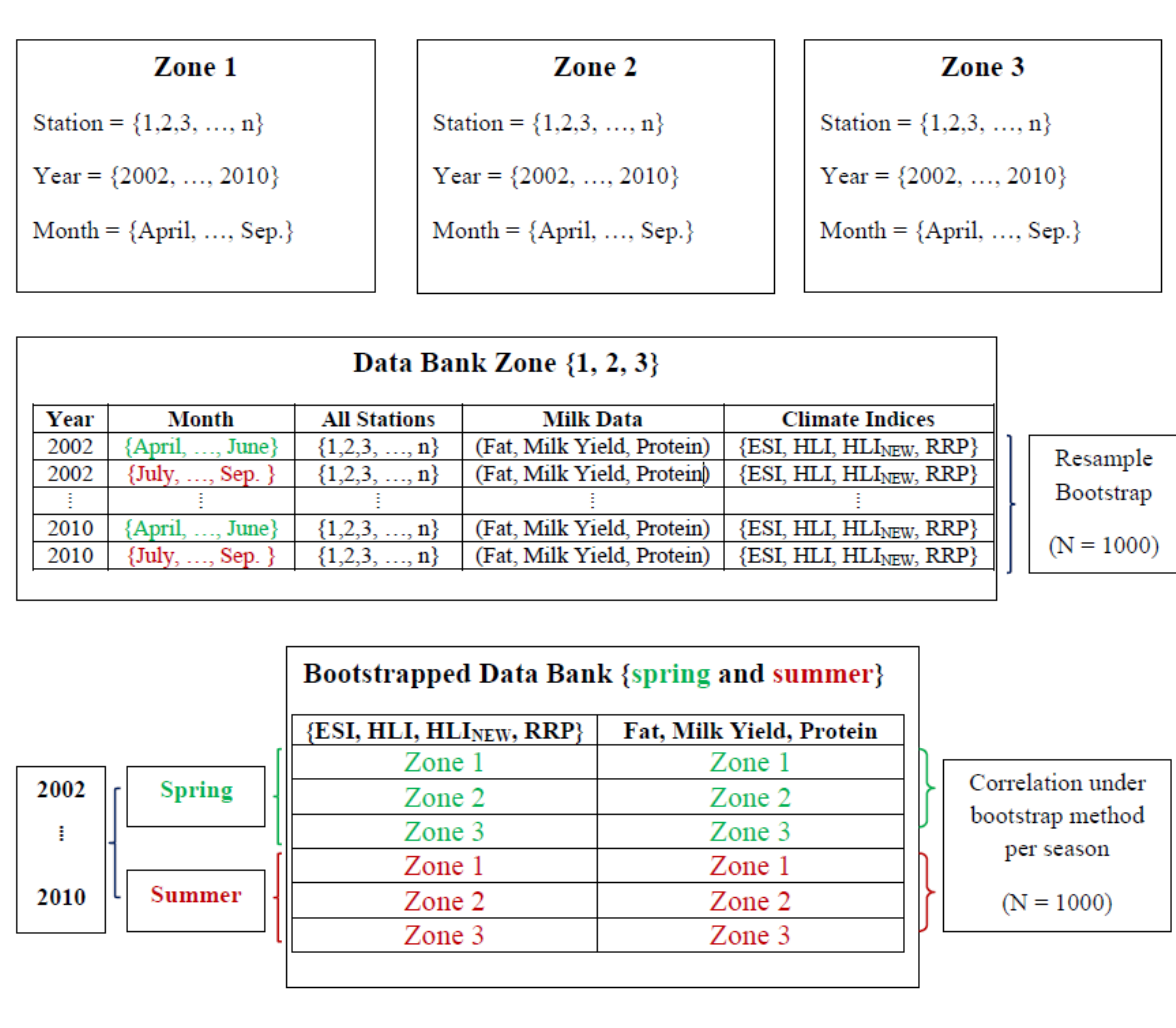
Figure 2. Structure of the climatic and milk parameter data